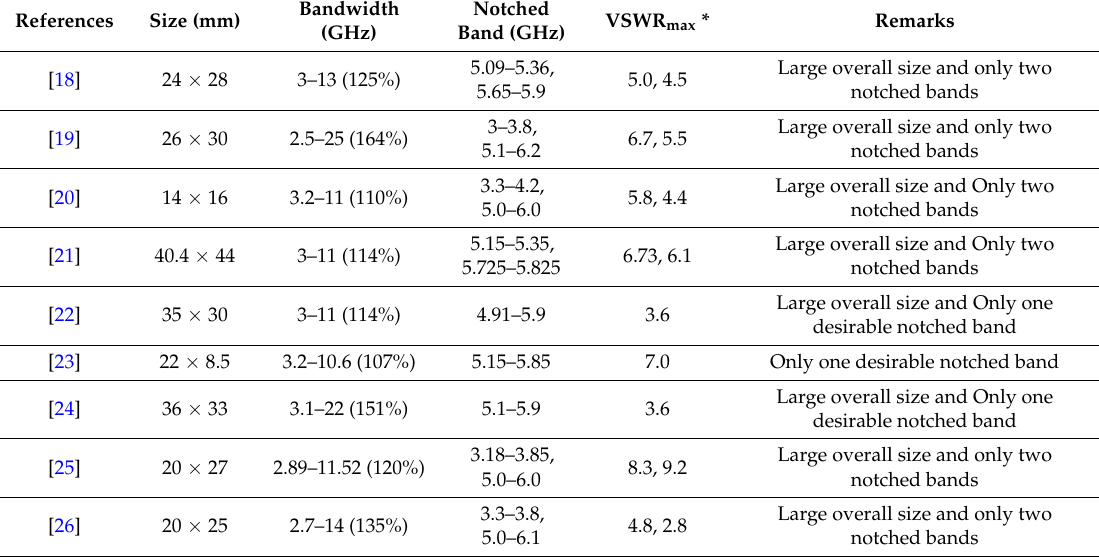
Table 2. Performance comparison of the proposed triple band-notched UWB antenna with other reported antennas.